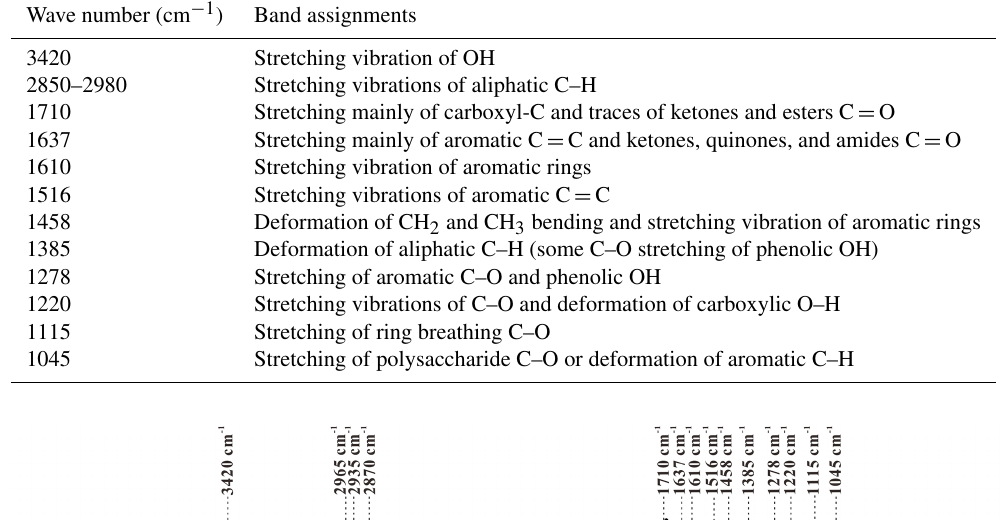
Table 5. Major band assignments for FT-IR spectra of HULIS in smoke PM 2 . 5 from biomass burning and coal combustion, and in ambient aerosols.